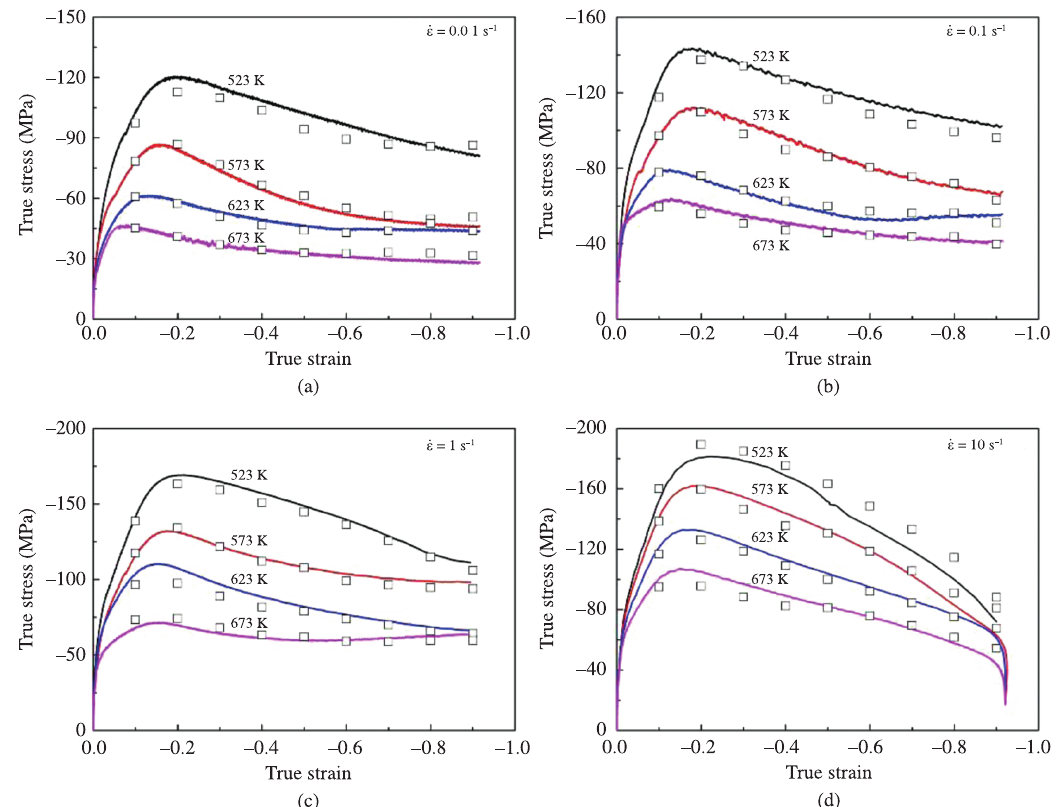
Figure 6. Comparisons between predicted and measured flow stress curves of AZ80 magnesium alloy under strain rates of: (a) 0.01 s –1 ; (b) 0.1 s –1 ; (c) 1 s –1 ; (d) 10 s –1